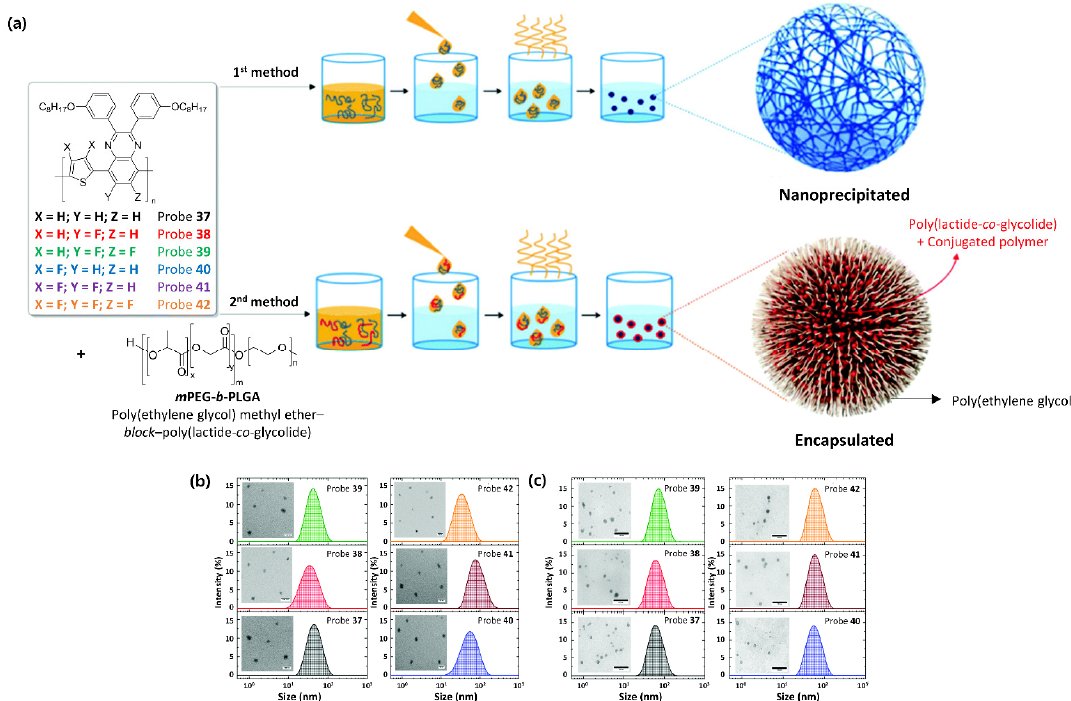
Figure 19. ( a ) Schematic representation of the conjugated polymer nanoparticles prepared through Figure 19. ( a ) Chemical structures of probe 48 and DSPE-PEG polymers and a schematic illustration nanoprecipitation (top) and encapsulation (bottom). ( b , c ) Photographs that confirm the morphology for probe 48 Pdots synthesis. Hydrodynamic size distributions of DSPE-PEG:probe 48 weight ratios of ( b ) 10:1 and ( c ) 2:1 in aqueous media. The insets are the corresponding TEM images of 10:1 and